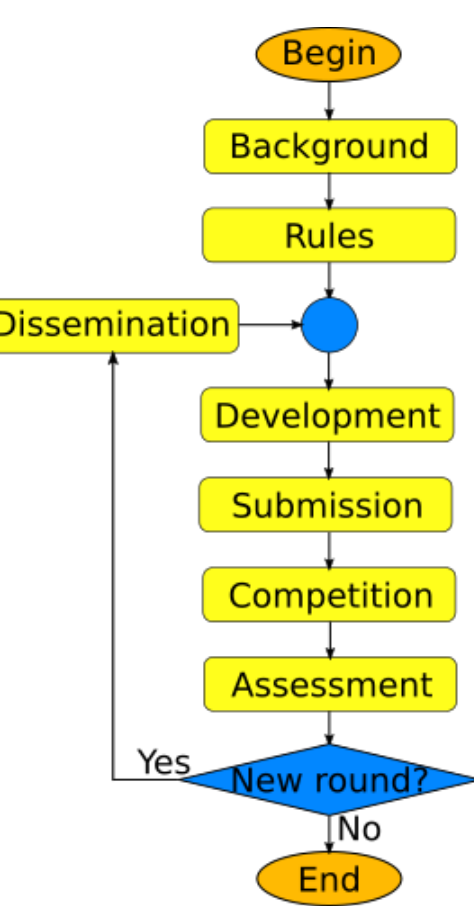
Figure 1. Proposed